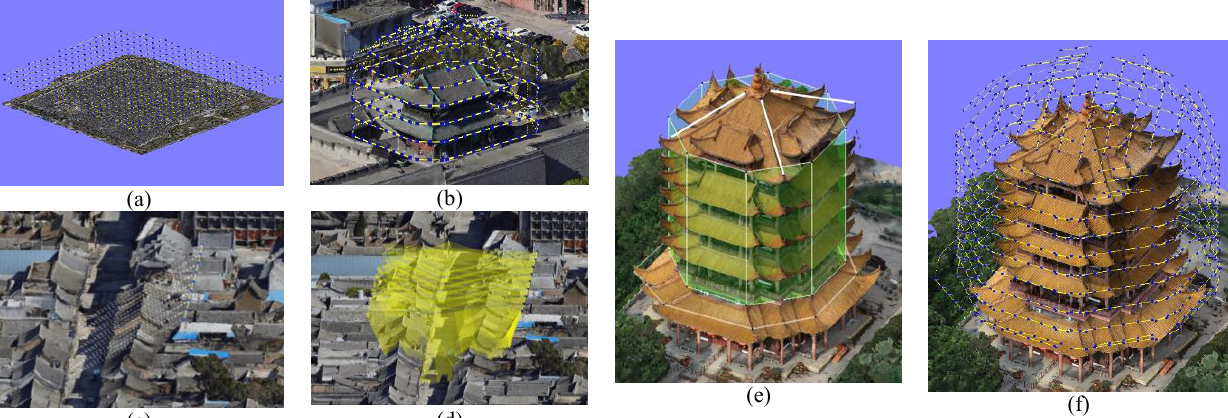
Figure 7 . Different path planning methods. (a) The vertical photography; (b) Path planning for the body object; (c) (d) The convergent photography; (e) Path planning for the combination of body and line objects; (f) The generated path for the Yellow Crane Tower.